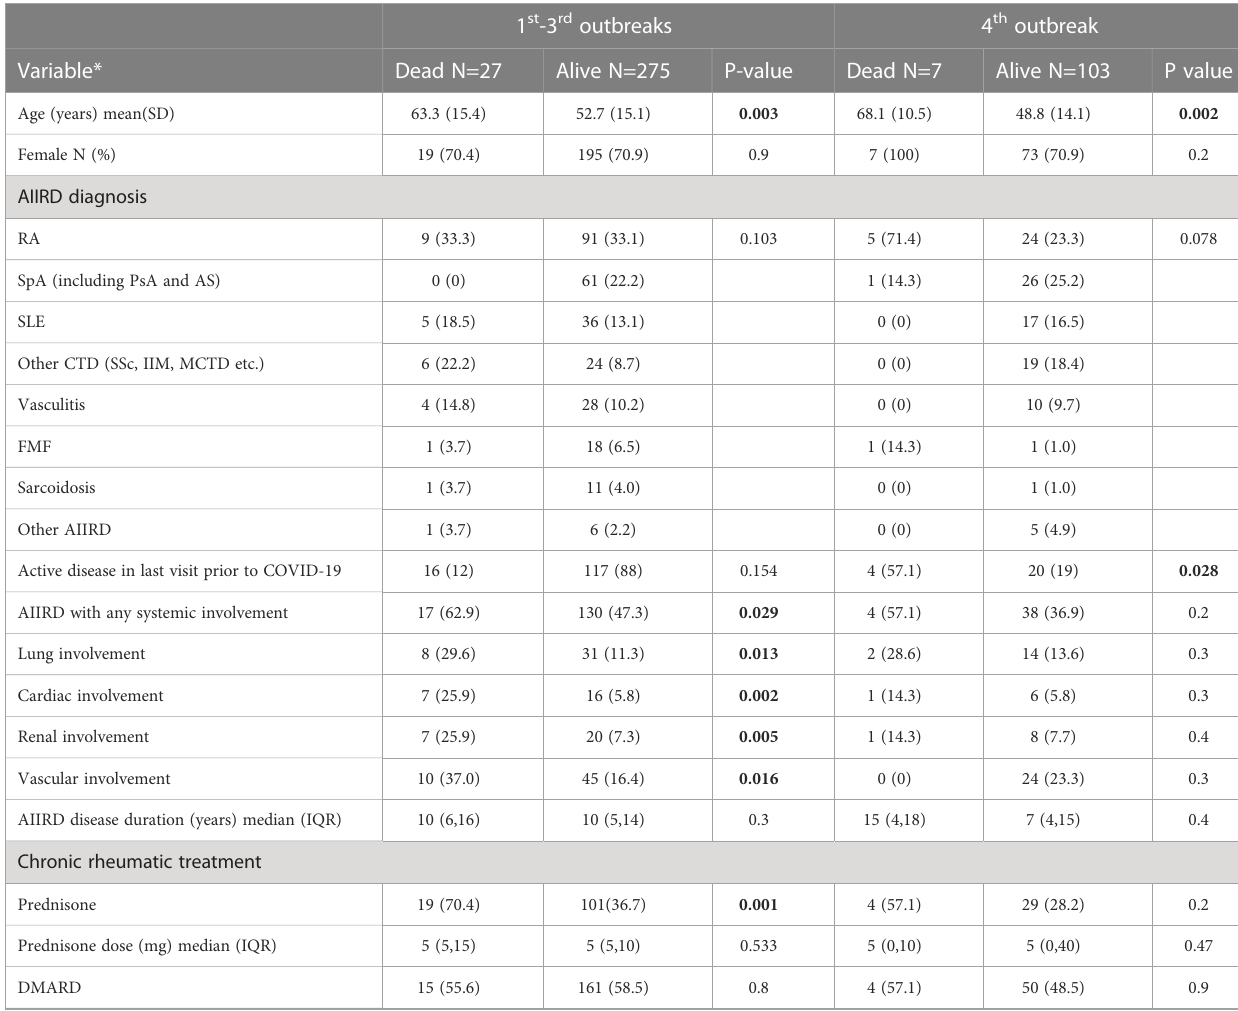
TABLE 5 Univariate analysis of demographic, clinical and COVID-19-related variables in regard to mortality. 1 st -3 rd outbreaks 4 th